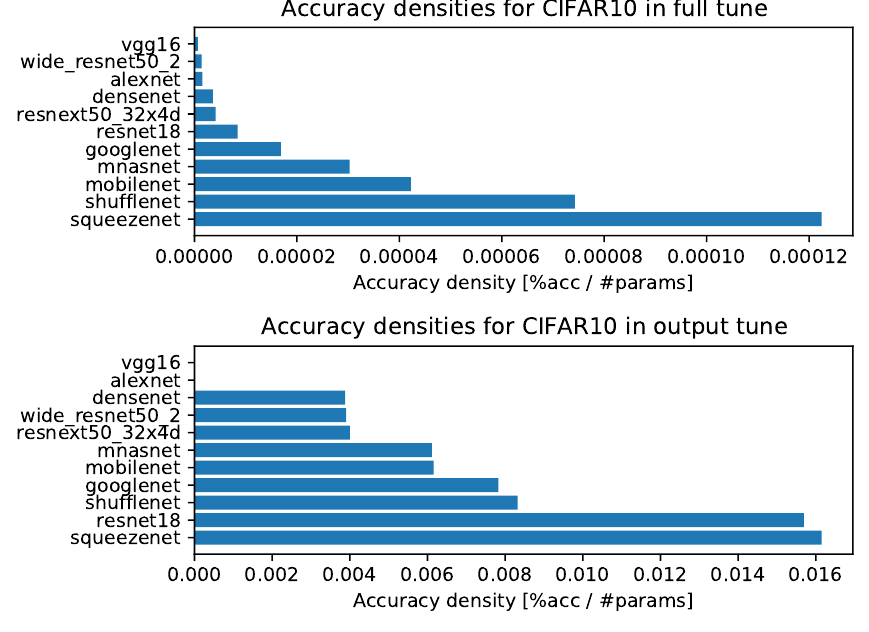
Figure A6. Accuracy densities for ten-episodes learning on